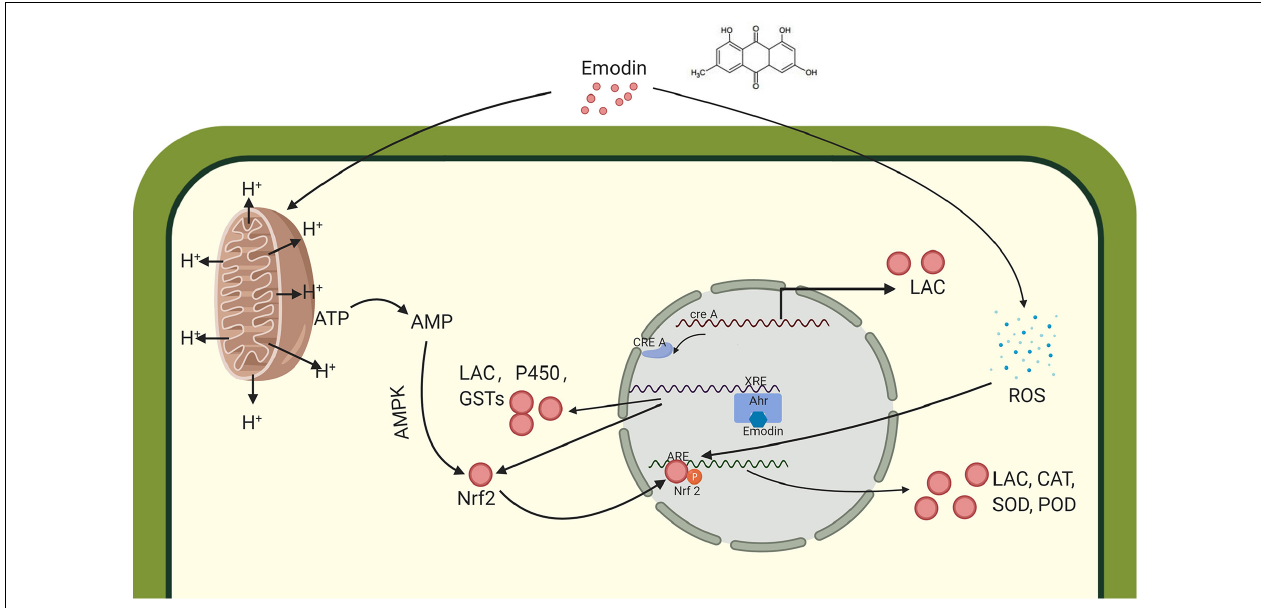
FIGURE 7 | Schematic illustration of the induction of laccase by emodin in Trametes versicolor